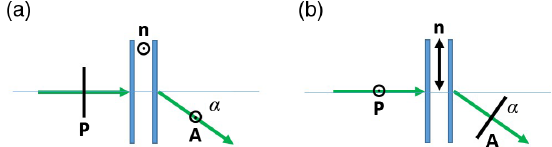
FIG. 12. DLS scattering geometries. (a) Splay ( α ¼ 35 °) and twist ( α ¼ 3 °), and (b) bend ( α ¼ 35